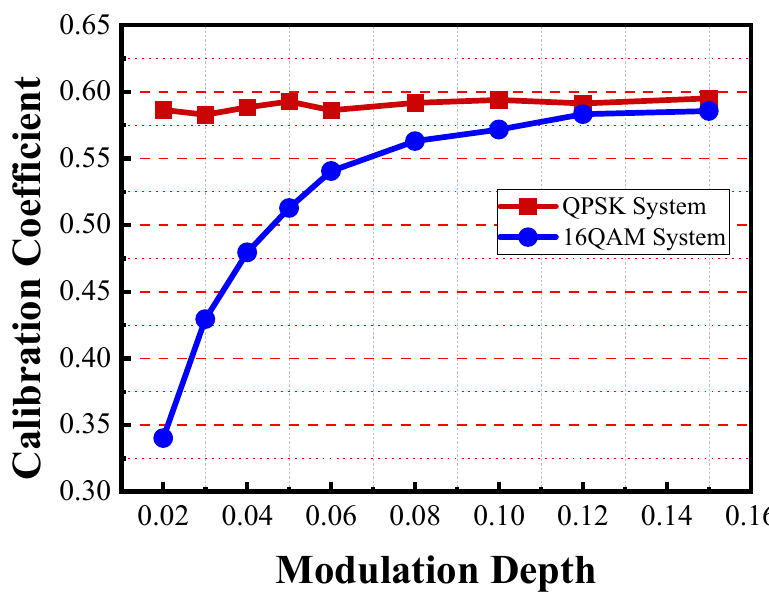
Figure 4. The calibration coefficient versus modulation depth.